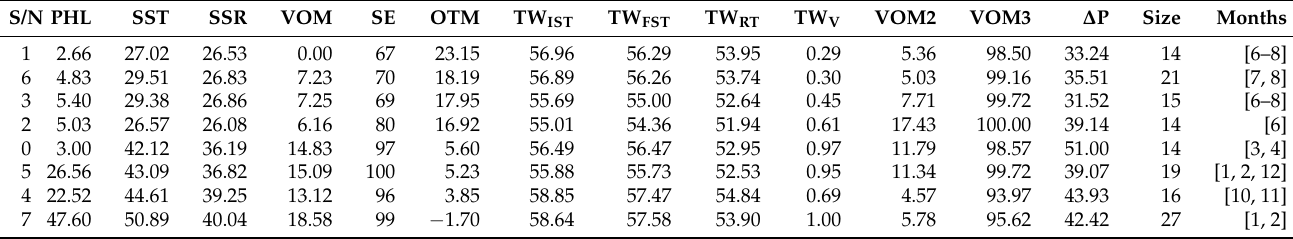
Table 16. Closed patterns from global model showing correlations between all six views after receiving chunk 2. Values are sorted based on OTM.